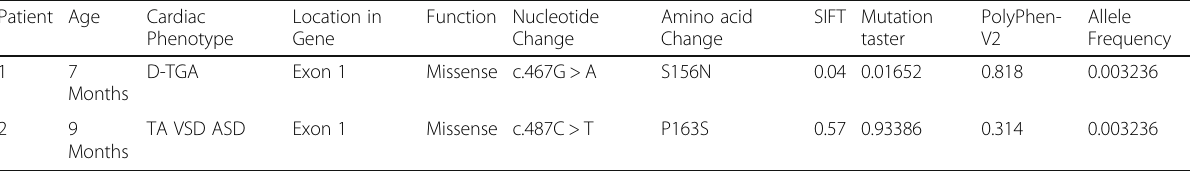
Table 2 Clinical and baseline characteristics of novel KLF13 variants in CHDs